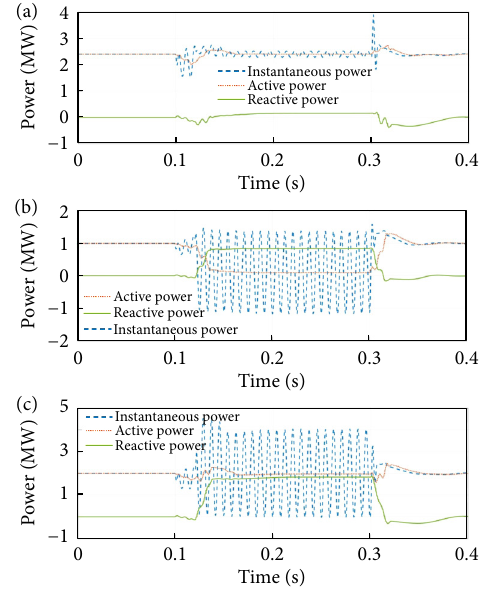
Fig. 7 Results for single-phase-to-ground faults with learning-based AFM. Power outputs of ( a ) microgrid 1, ( b ) microgrid 2, and ( c ) microgrid 3, including instantaneous power, active power, and reactive power.